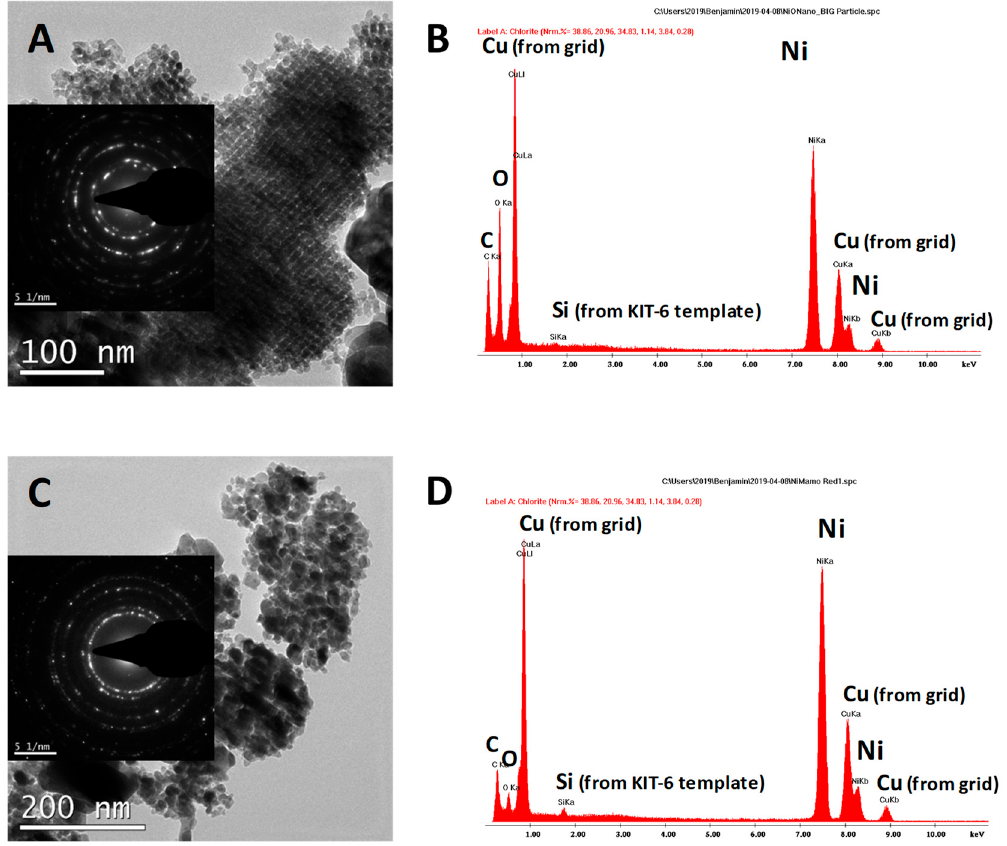
Figure 3. Representative TEM images with the corresponding selected area electron diffraction (SAED) patterns (inset) for ( A ) NiO precursor of NiNC and ( C ) NiNC catalyst. EDX analyses of ( B ) NiO precursor of NiNC and ( D ) NiNC catalyst.